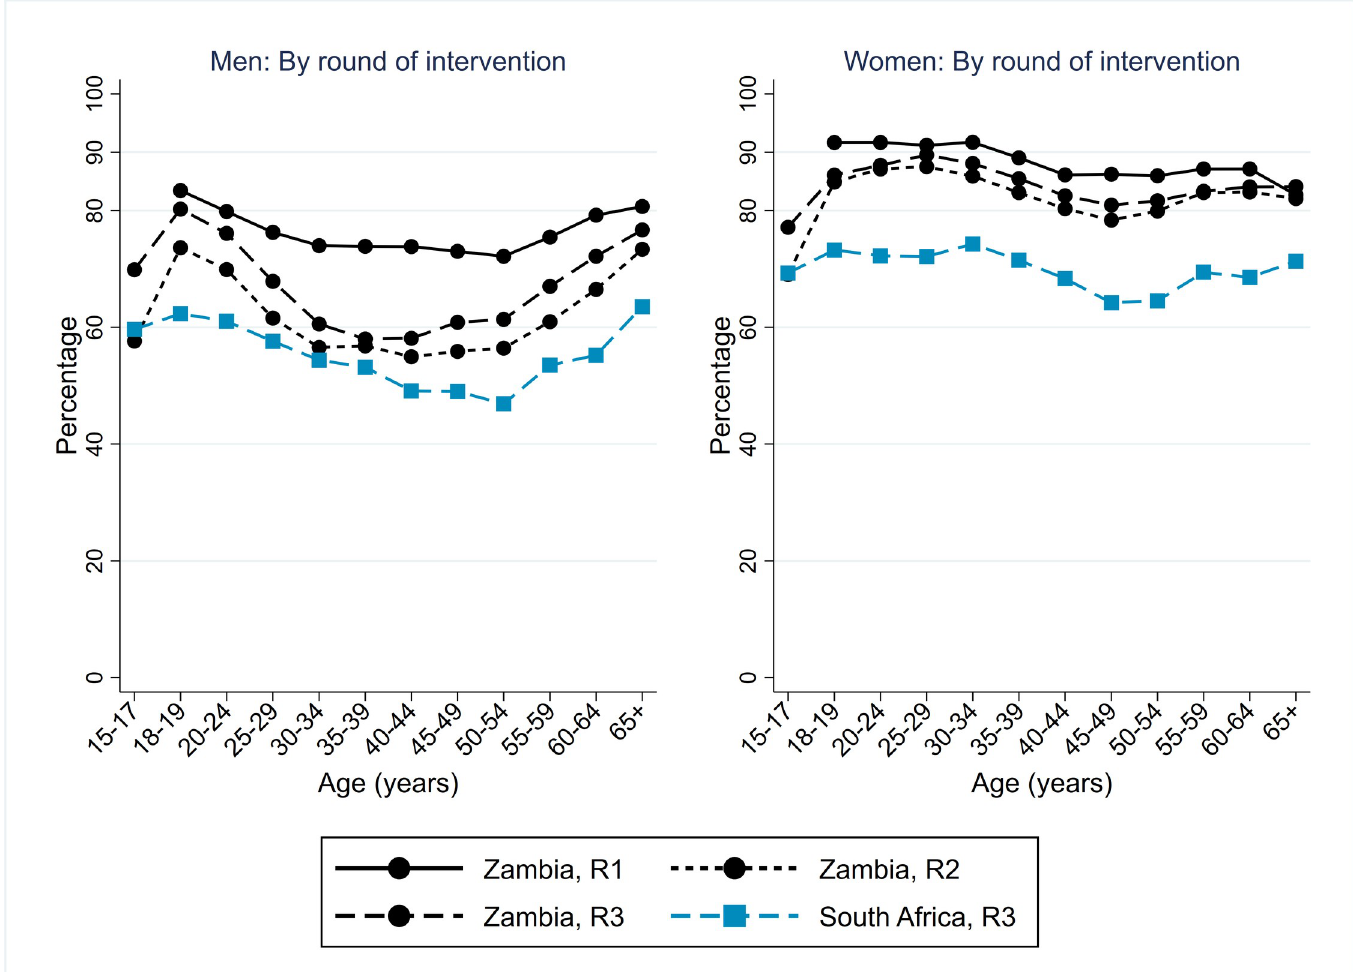
Fig 2. Arm A: Participation in the PopART intervention, Zambian communities R1–R3, and SA communities R3, by sex and age group. R1, Round 1; R2, Round 2; R3, Round 3; SA, South